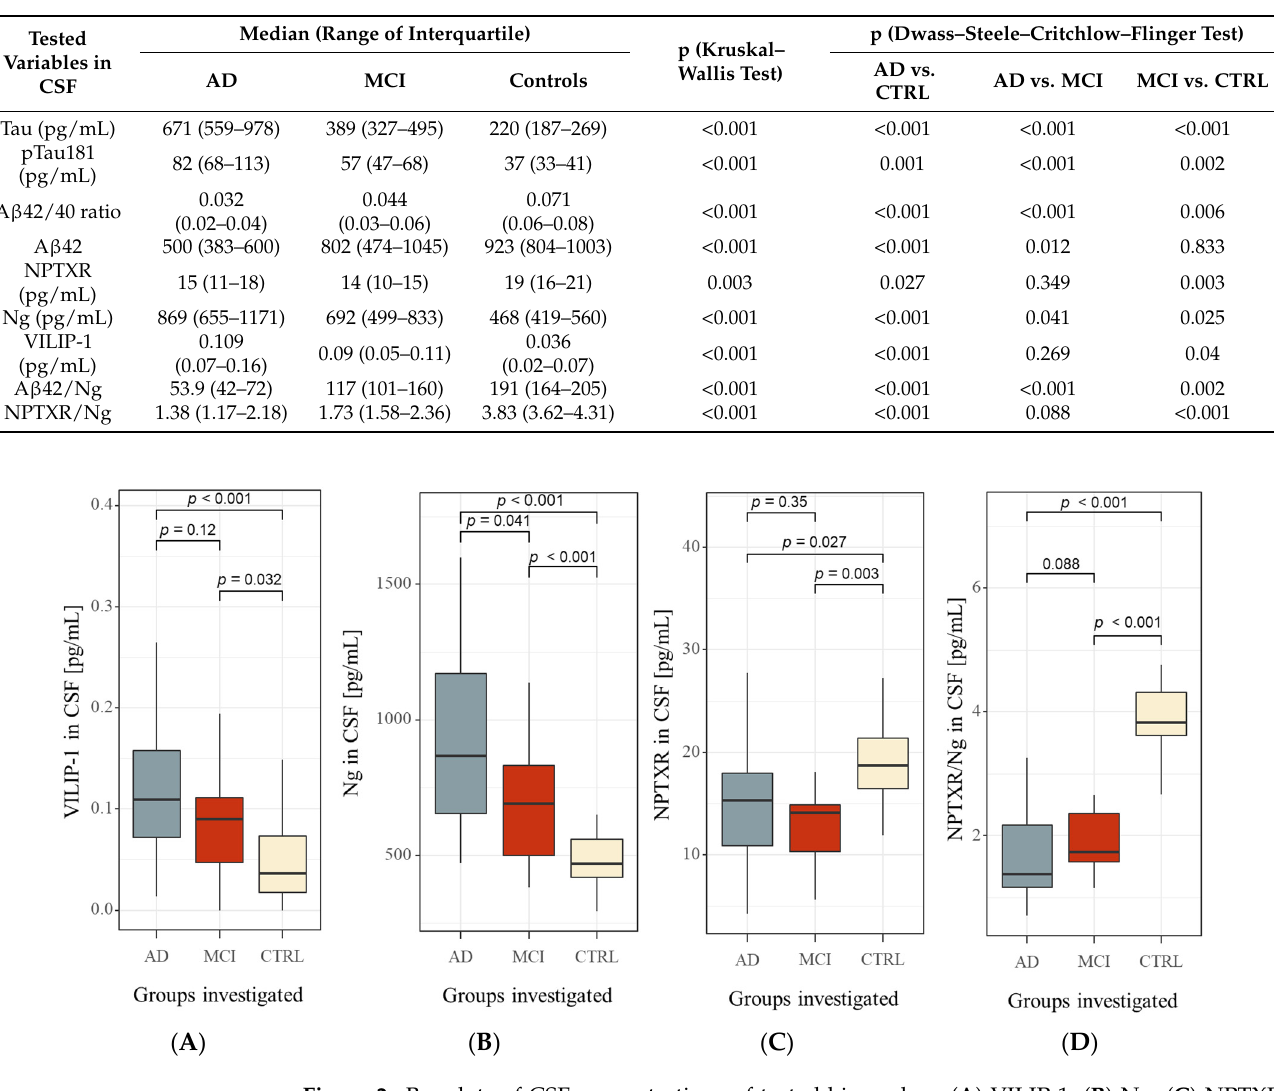
Figure 2. Boxplots of CSF concentrations of tested biomarkers ( A ) VILIP-1, ( B ) Ng, ( C ) NPTXR, and ( D ) NPTXR/Ng in examined groups. Abbreviations: cerebrospinal fluid (CSF), Visinin-like protein 1 (VILIP1), neurogranin (Ng), neuronal pentraxin receptor (NPTXR), neuronal pentraxin receptor/neurogranin ratio, Alzheimer’s disease (AD), mild cognitive impairments (MCI), control group (CTRL).